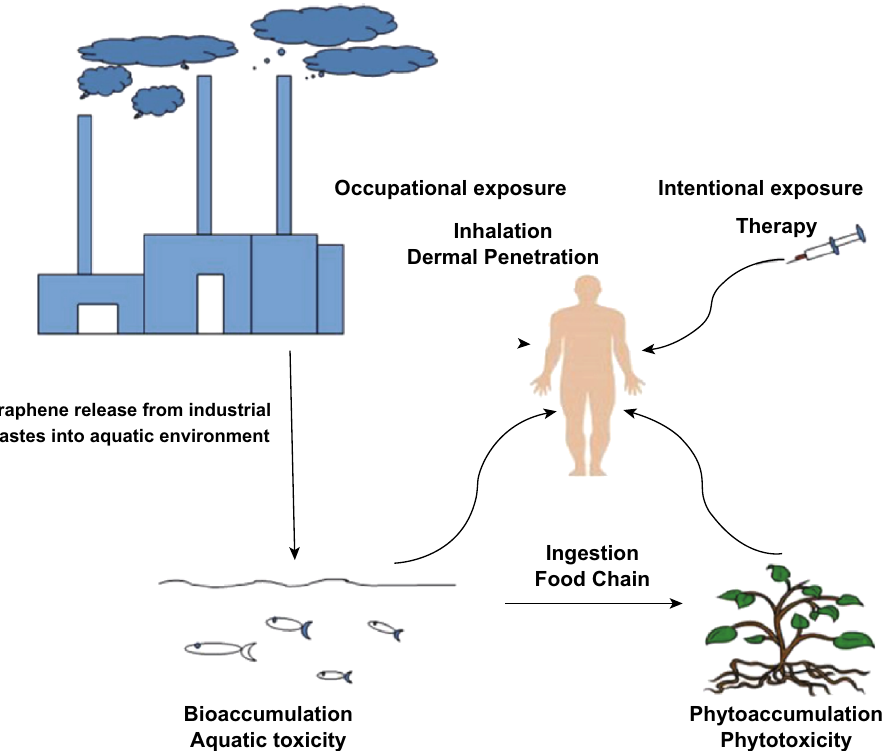
Fig. 8 Human exposure to graphene from the environment: Humans are exposed to nanomaterials either intentionally in the form of therapy or unintentionally via various factors especially during the manufacturing process in industries. Graphene can enter ecosystem mainly through waste disposal from industries or pharmaceuticals, posing a threat to aquatic organisms. Stable graphene that exists in soil or water can enter the human body through food chain [151]. Copyright (cid:2) 2016 Elsevier